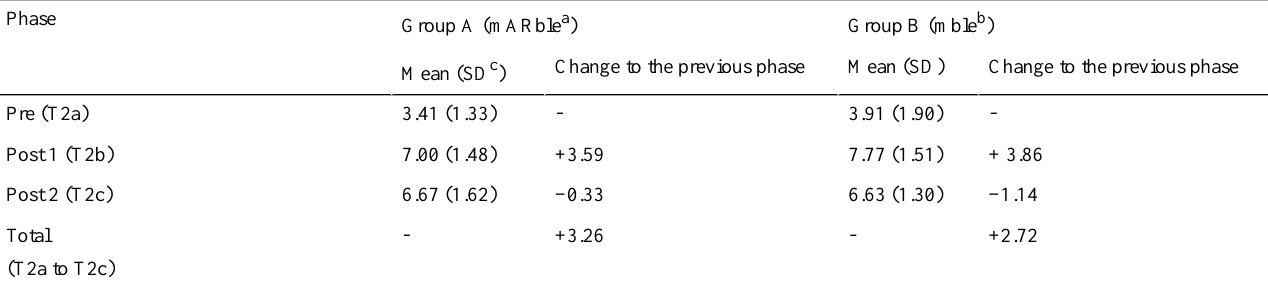
Table 3. Results (number of correctly answered questions) and changes for the single choice tests administered during the